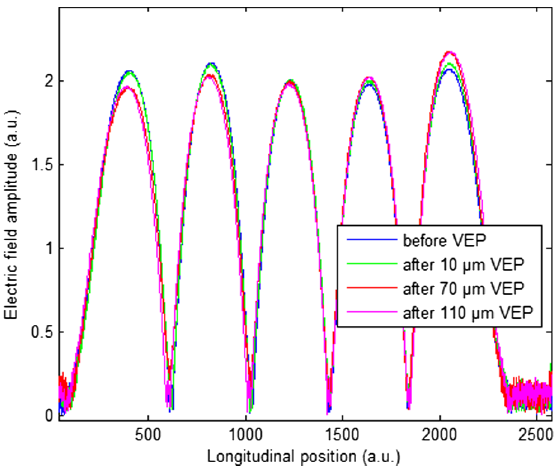
FIG. 15. Field flatness evolution after each VEP sequence. After the second sequence (uncontrolled process), a shift is observed. No deterioration is noticed once the hydrogen problem has been solved.